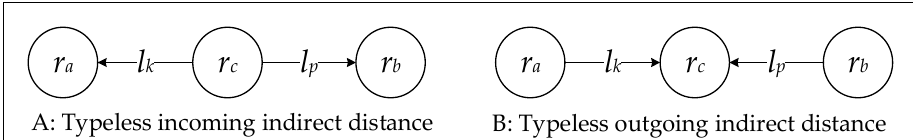
Figure 3. Typeless indirect distance.